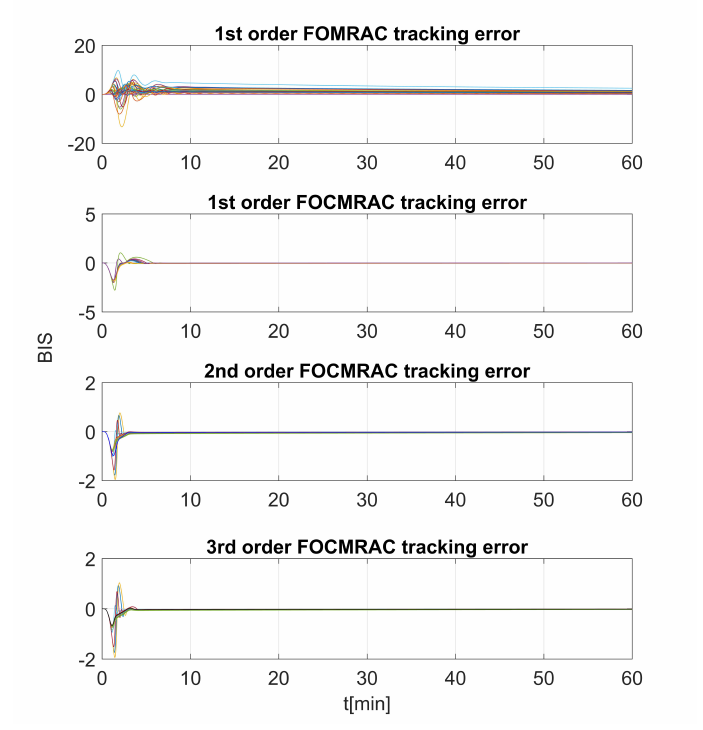
Figure 11. Tracking errors of the FOMRAC and FOCMRAC schemes with the 30 virtual patients. In Figures 12–15 are shown the evolution of the controller